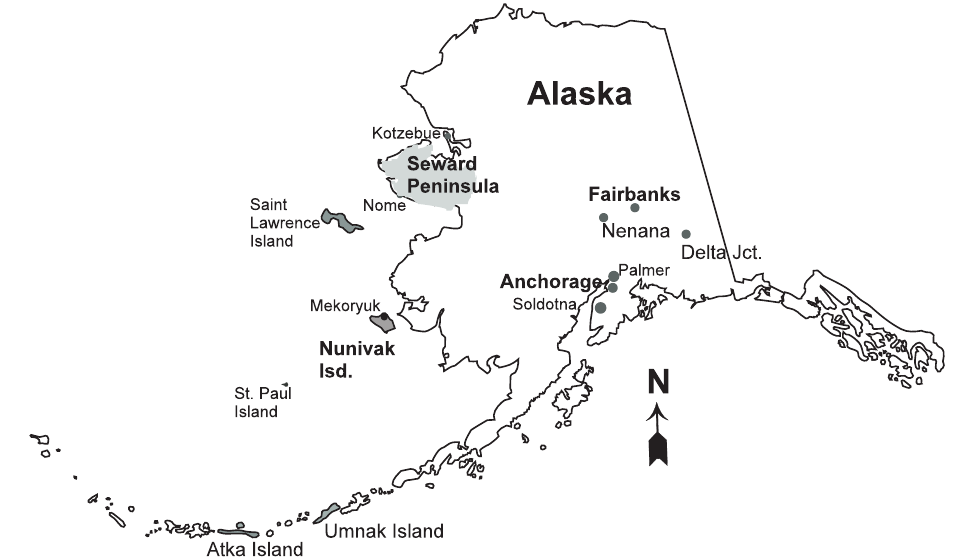
Fig. 1. Nunivak Island in relation to other reindeer herds in the State of Alaska,